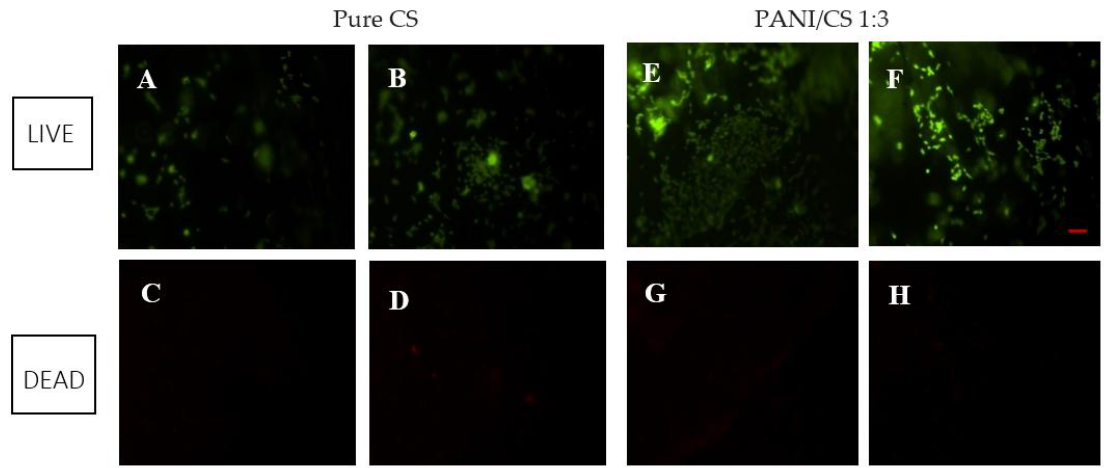
Figure 4. Fluorescence LIVE/DEAD stain for membranes (3 d in culture): ( A , B ) live at two different chitosan membrane regions, ( C , D ) dead staining for the same chitosan membrane regions; ( E , F ) live at two different PANI/CS membrane regions, ( G , H ) dead staining for the same PANI/CS membrane regions. Live and dead images were taken from the exact same spot of the membrane surface, and at the same magnification ( × 4), by changing filters on the